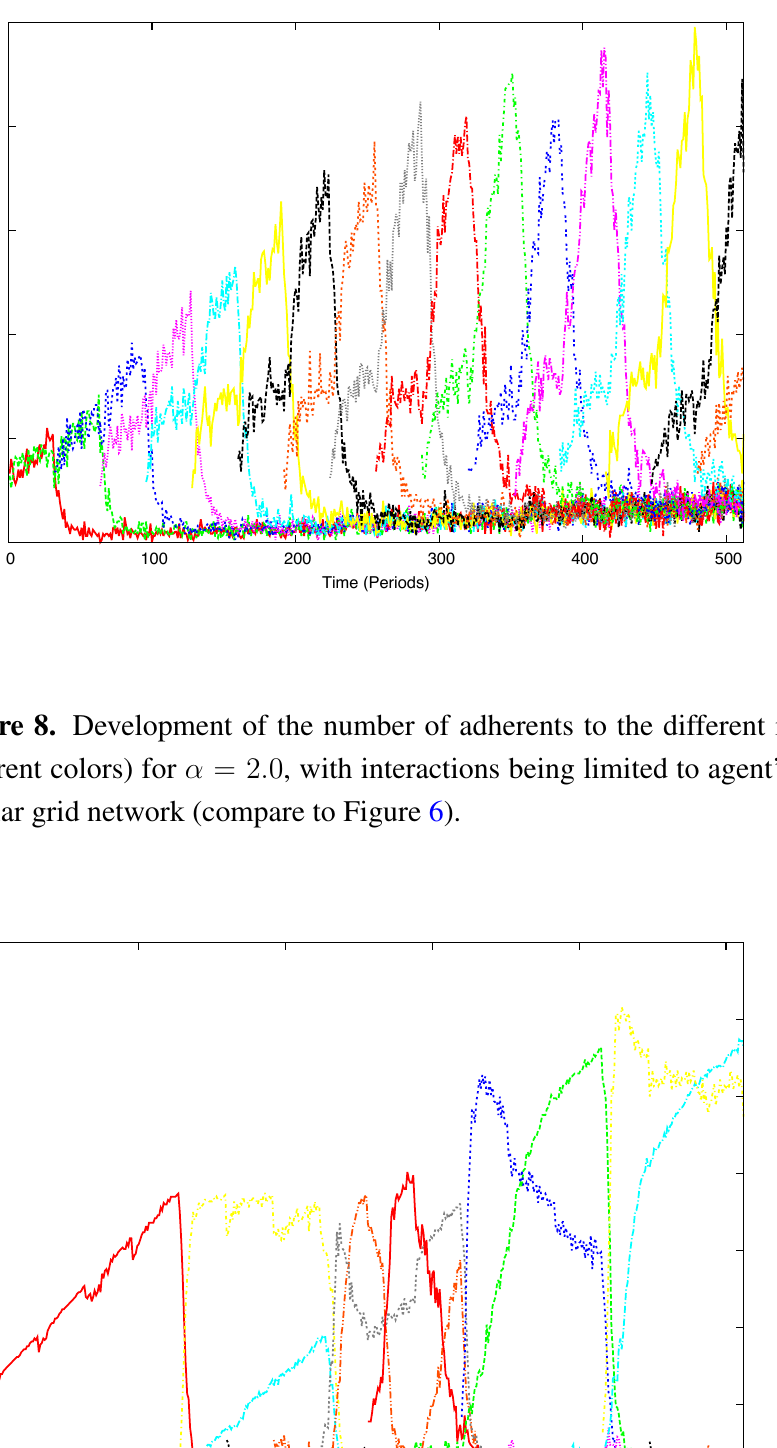
Figure 7. Development of the number of adherents to the different institutions (shown in different colors) for ↵ = 3 . 0 .